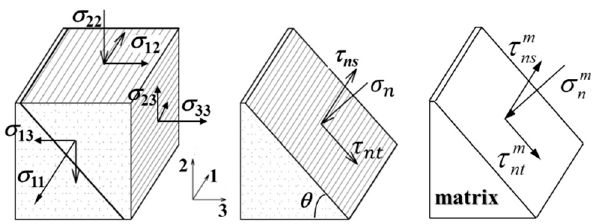
Figure 11. Schematic of matrix compression-induced composite failure surface.